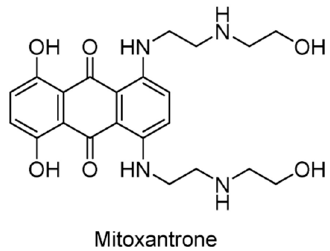
Figure 20. Structure of mitoxantrone.